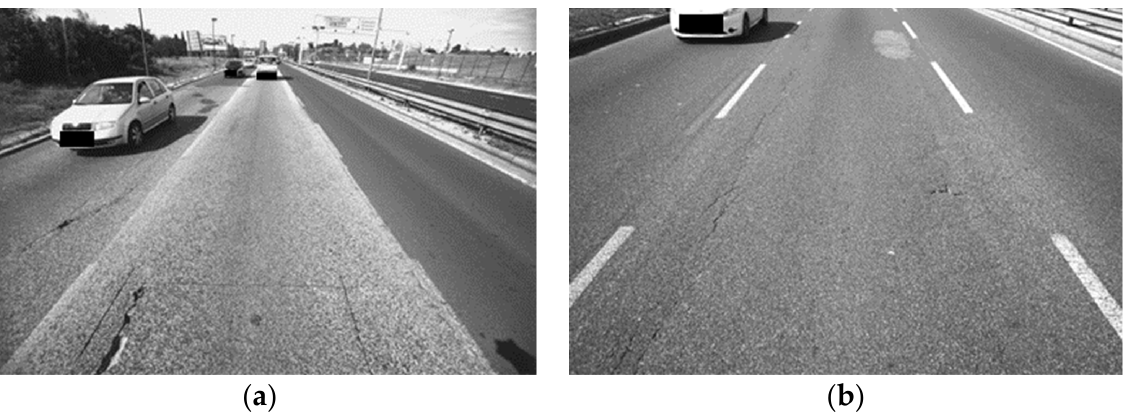
Figure 7. Images captured with a slant angle of 30° and a camera focal length of: ( a ) 16 mm; ( b ) 28 mm.